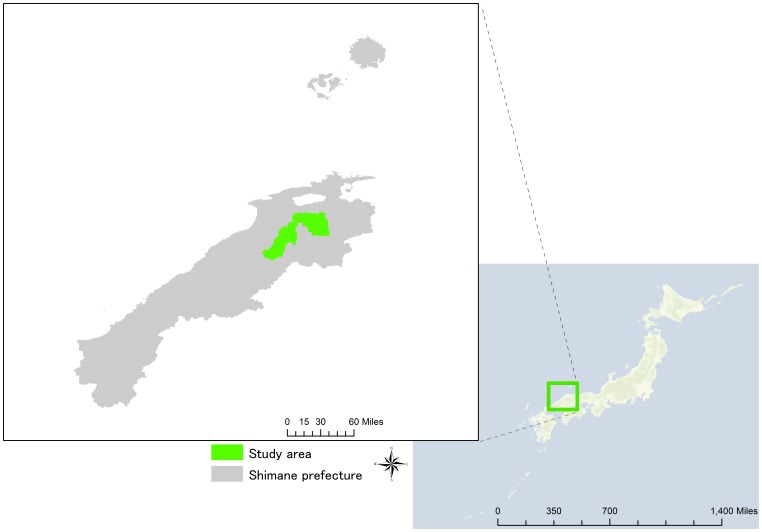
Map of study area.